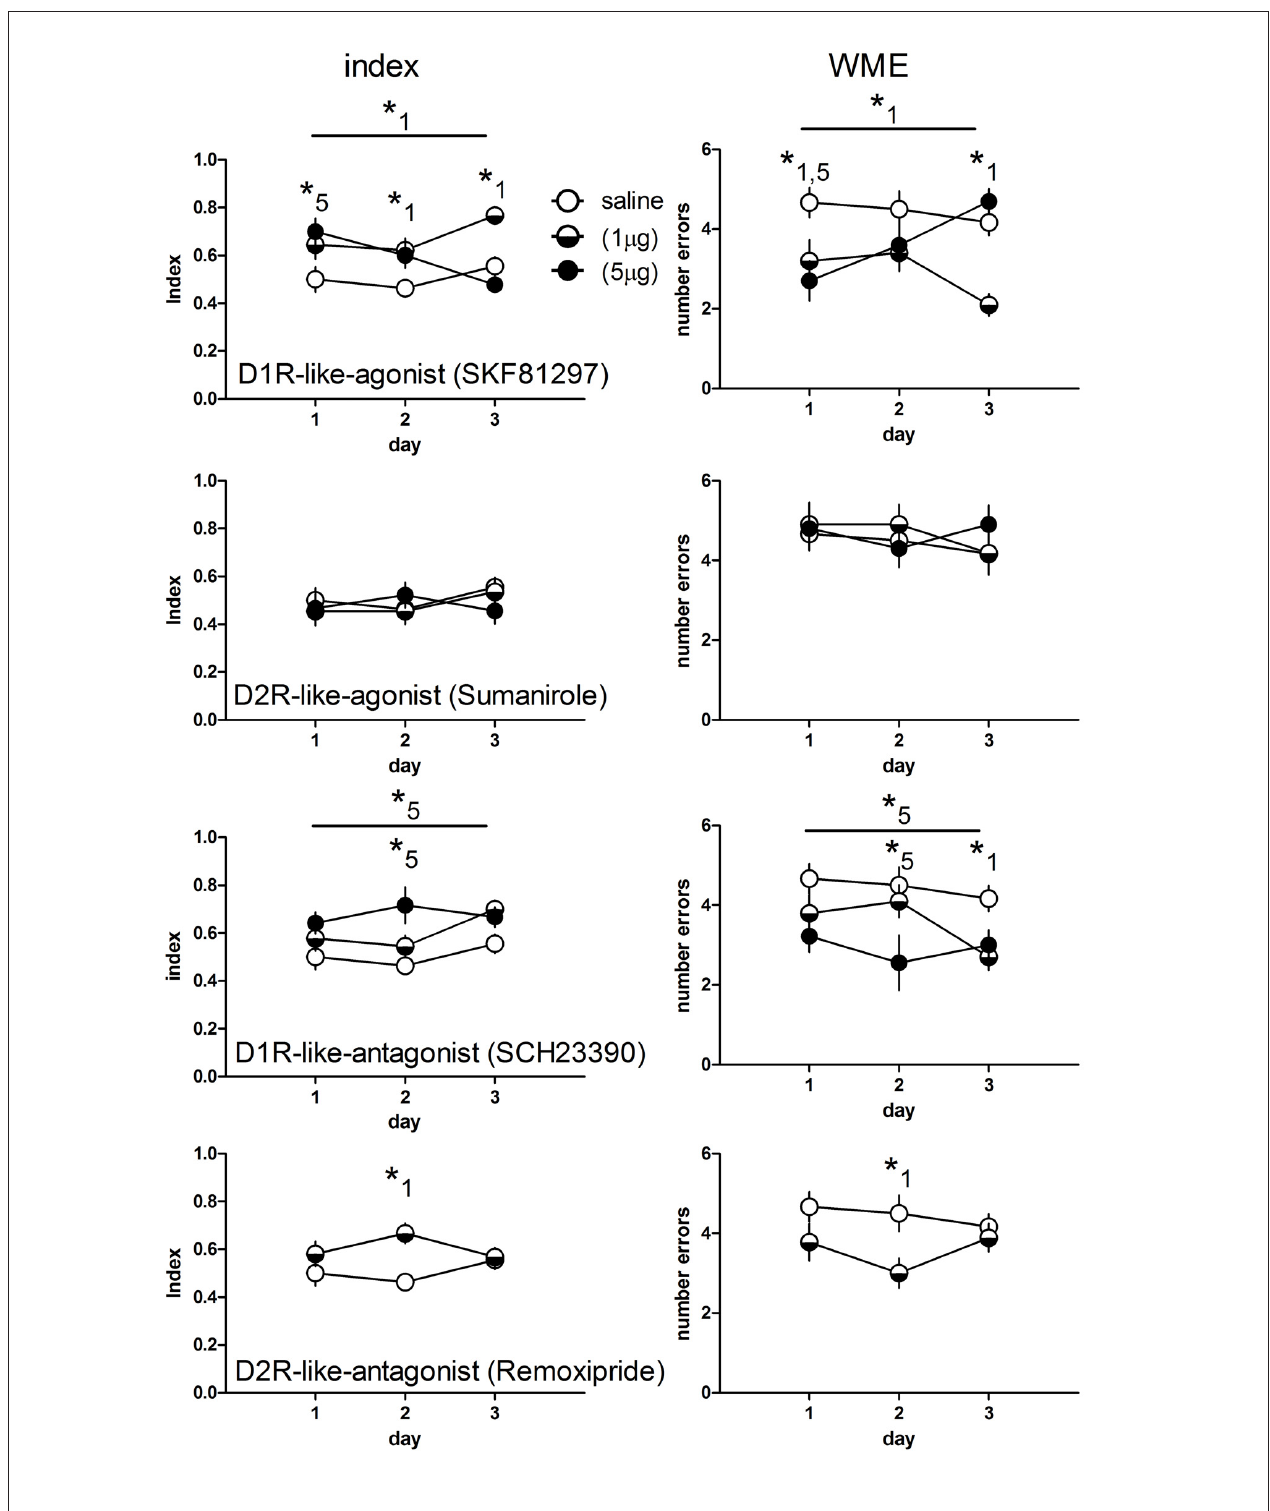
FIGURE 1 | Working memory indices (left panel) and numbers of working memory errors (WME, right panel) of rats treated with an D1- ( n = 10 each) and D2-like agonist (1 µ g: n = 11; 5 µ g: n = 10) for each dose) and antagonist (D1: 1 µ g: n = 10; 5 µ g: n = 9; D2: n = 9) or saline ( n = 12). Significant differences between groups over the entire training are indicated by an asterisk above horizontal bars. Significant differences between groups for specific days are indicated by asterisks above daily data points. Numbers give the drug dose (1: 1 µ g; 5: 5 µ g). Given are the mean values and SEM.